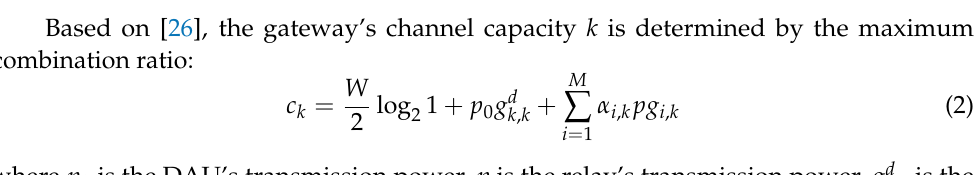
Figure 1. Cooperative communication network